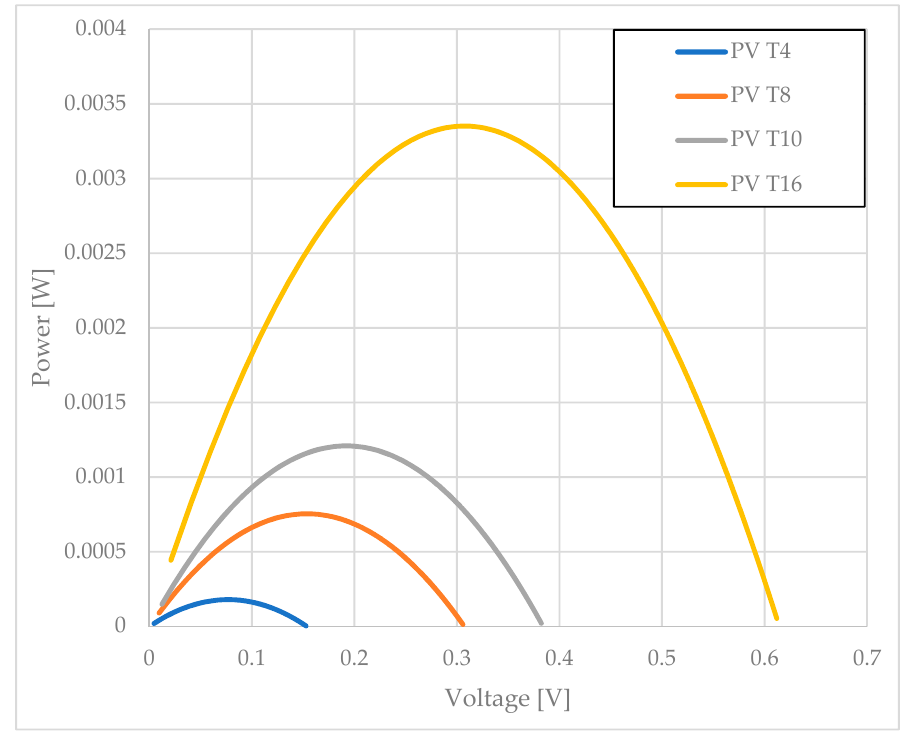
Figure 10. Power-voltage simulation analysis for 12 cells connected in series with Δ T = 16 °C (yellow), Δ T = 10 °C (grey), Δ T = 8 °C (orange), and Δ T = 4 °C (blue).